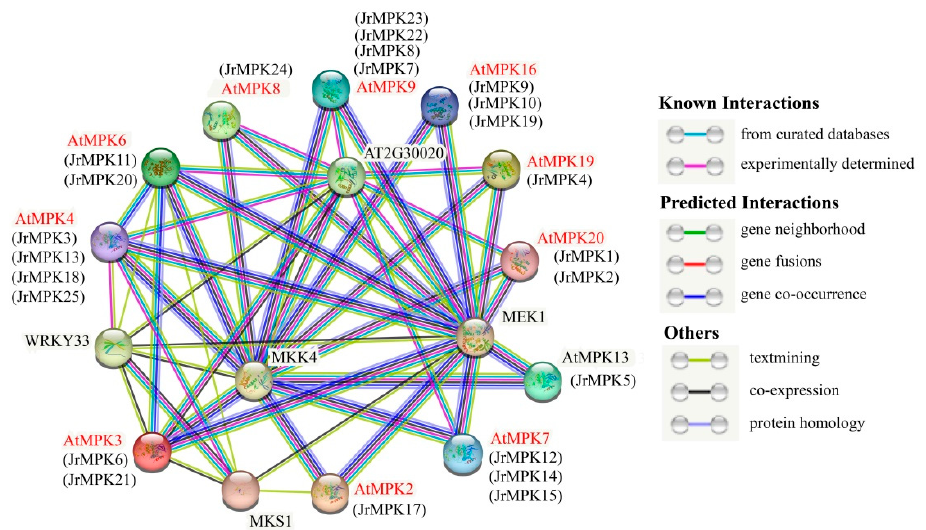
Figure 9. MAPK protein interaction network diagram. Proteins are represented by the network nodes. The 3D structure of the protein is displayed inside the node, and the line color indicates the type of interaction evidence.